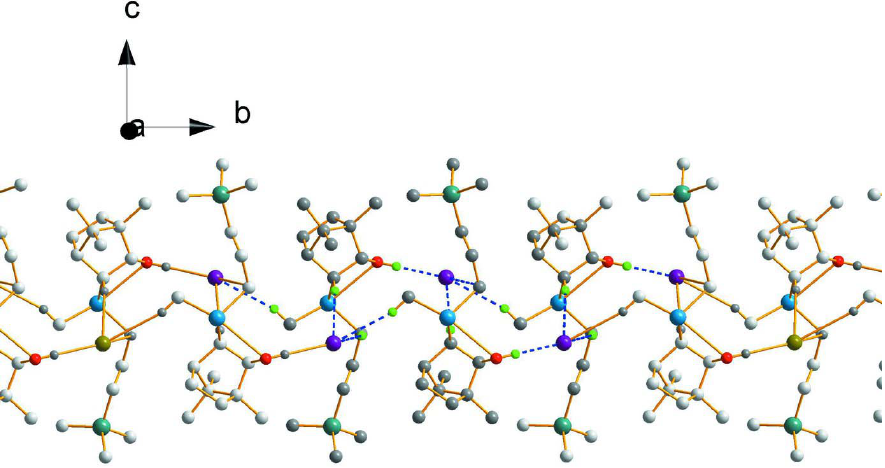
Figure 2 A view of the onedimensional R -helical chains along the [010] axis. H atoms have been omitted for clarity, except for H1D, H5, H11 c , and H12B which are involved in hydrogen